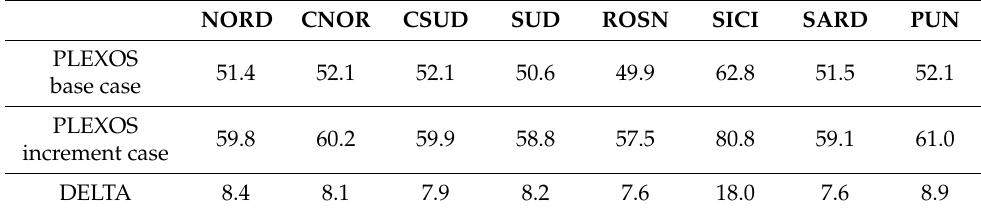
Table 3. Zonal prices and PUN of Plexos base case compared to reserve increment